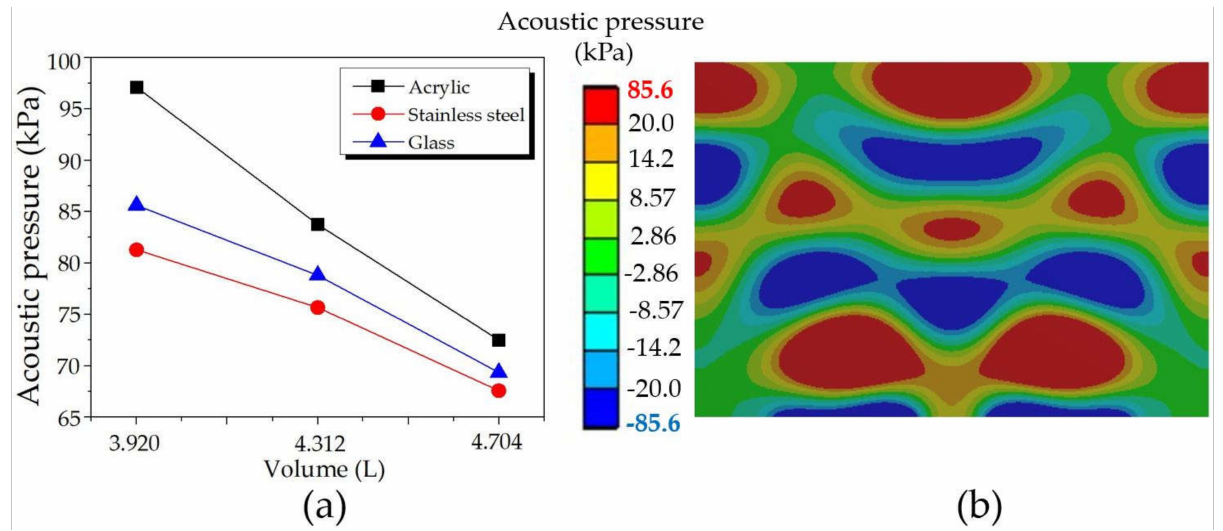
Figure 14. The maximum acoustic pressures: ( a ) comparison results for varying volume and tank